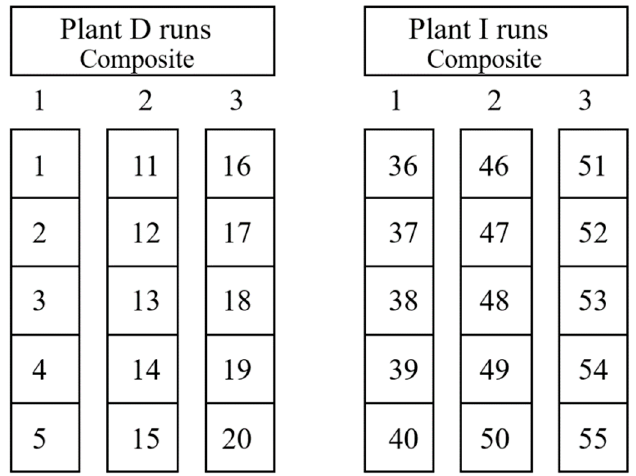
Figure 9. Design of analysis of variation outline for the evaluation of C, CaO, SO 3 , Fe 2 O 3 , and REE.